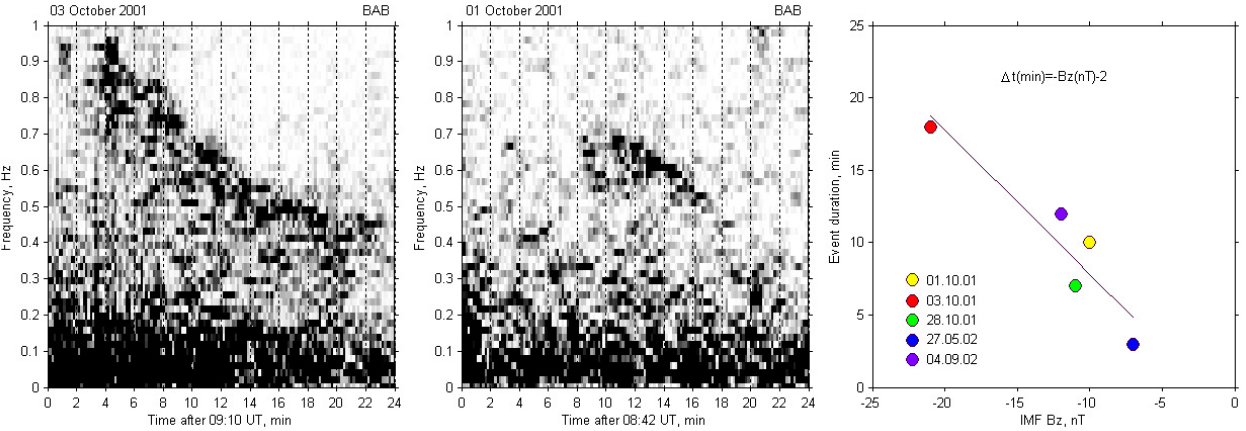
Fig. 8. Two examples of BAB Pc1 in which the frequency decreases with time. A plot illustrating the relationship of Pc1 event duration, 1 t, and the IMF B z magnitude.